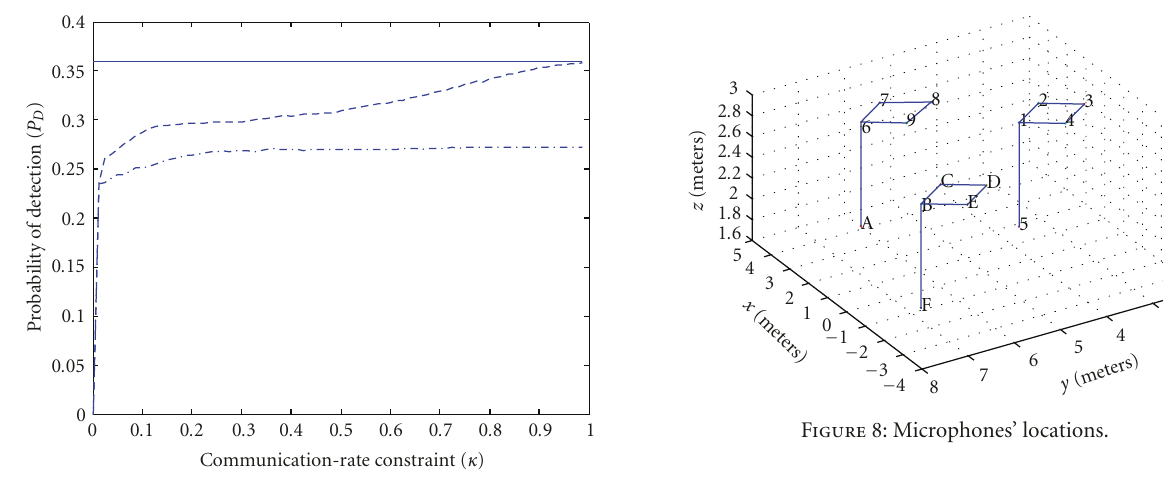
The performance loss due to using the optimal indepen- dent test is higher compared to the mGLRT as the correlation increases. However, when the sensors’ observations are of equal variance and all observations are highly correlated, the performance of the optimal independent test matches that of the mGLRT. The reader is referred to [13] for a more thorough comparison between the mGLRT and the optimal independent test.